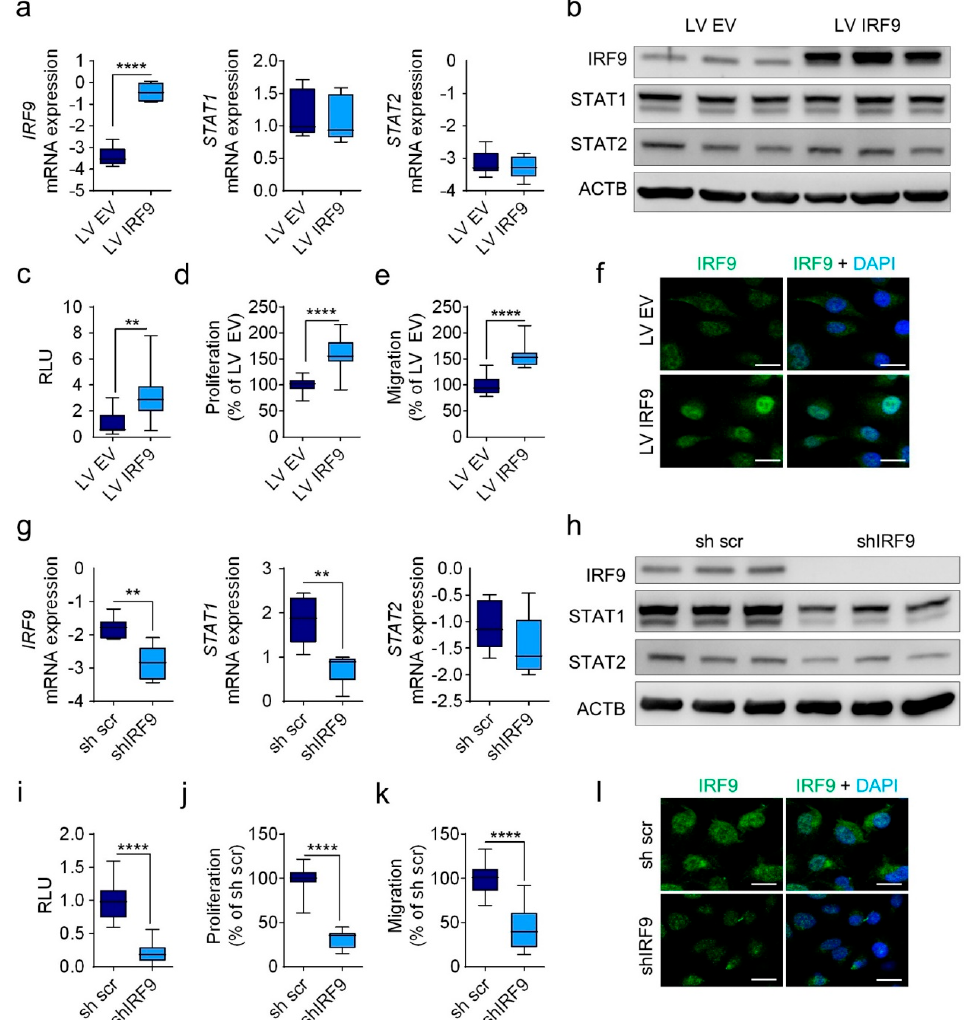
Figure 3. IRF9 overexpression and silencing of regulates the proliferative and migratory behavior in lung adenocarcinoma cells. Using lentiviral particles, A549 cells were transduced to overexpress (A549 LV IRF9) or knock down (A549 shIRF9) IRF9 . An empty vector (A549 LV EV) or scrambled sequence (A549 sh scr) was used as the respective control. ( a , g ) The mRNA expression levels of the indicated genes in the transduced cell lines were evaluated using RT-qPCR and the protein levels ( b , h ) by Western blot analysis. ( c , i ) IRF9 activity in relative light units (RLU) was measured using a luciferase reporter gene assay with an interferon stimulated response element (ISRE)-containing luciferase vector. ( d , j ) Proliferation and ( e , k ) migration in the transduced A549 cells were evaluated as a percentage of the control. ( f , l ) Immunocytochemistry staining of IRF9 (green) was revealed by an AlexaFlour 488 secondary antibody in transduced cell lines, and counterstained with DAPI (blue). Scale bars: 50 µm. Data are expressed as means ± standard error of the mean. Analysis performed using one-way analysis of variance with Welch’s t -test: ** p < 0.01; **** p < 0.0001 ( n = 3)